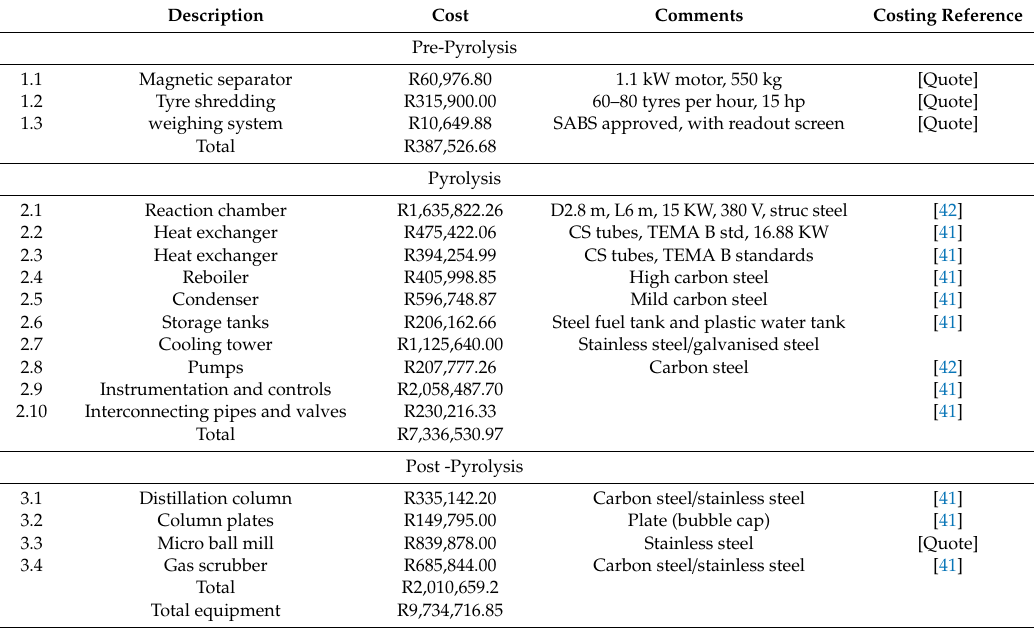
Figure 2. Temperature correction factor: two shell passes, four or multiples of four tube passes [41]. Table 4. Plant major equipment Table 3. Temperature (F T ), pressure (F p ), and material of construction correction factor (F M ) [42].